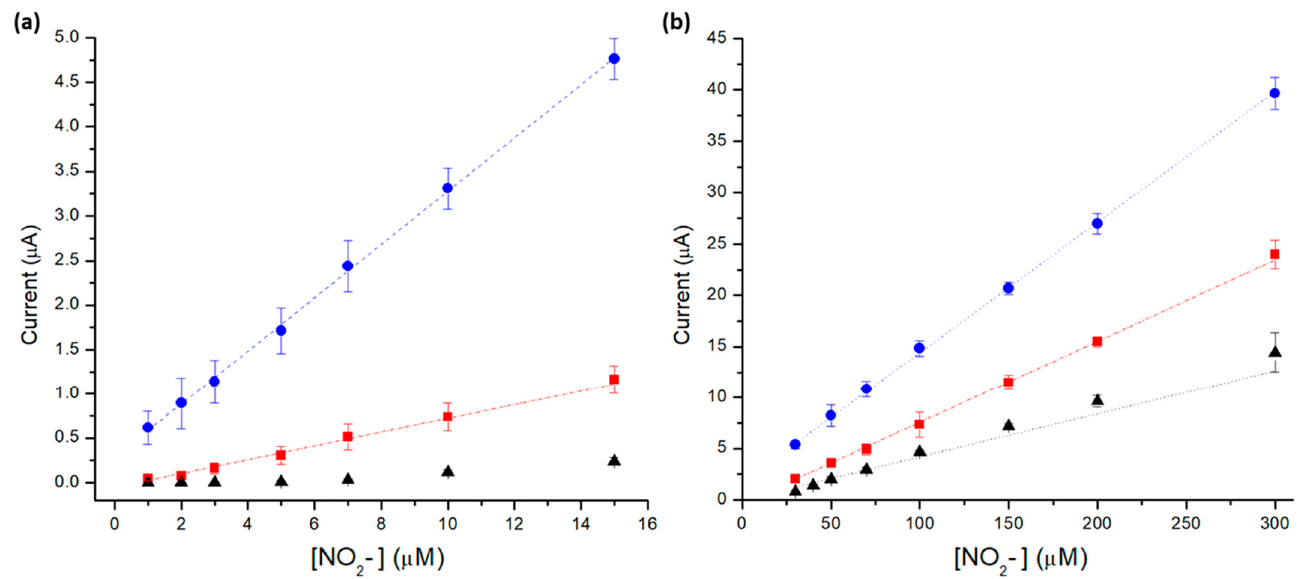
Figure 2. Plot of anodic peak currents vs. concentration of nitrites for bare GCE (black triangles), HMT-PMBI (red squares) and HMT-PMBI/NGNP coated electrodes (blue circles)—( a ) from 1 µM to 15 µM; ( b ) from 30 µM to 300 µM. The supporting electrolyte was 0.1 M NaCl and scan rate was 0.1 V s − 1 . Error bars were calculated from three repeat measurements.